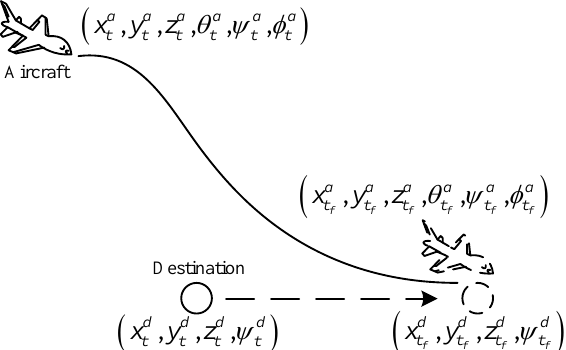
Figure 1. Aircraft guidance problem in three dimensional continuous